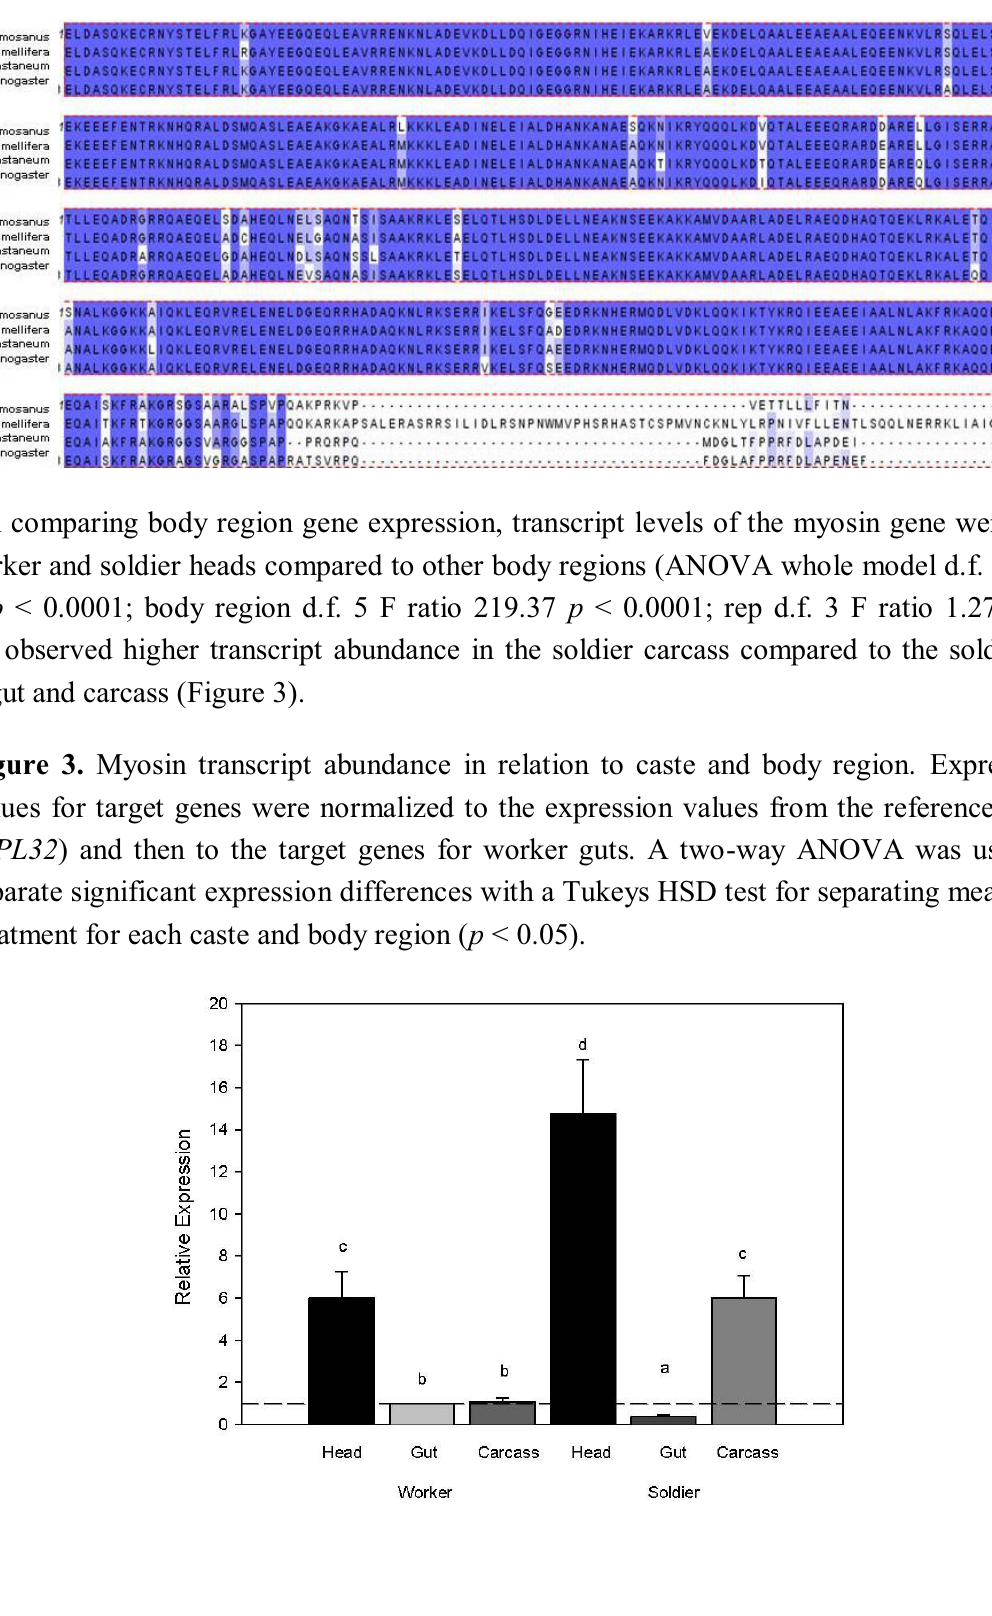
Figure 2. The predicted translation of available C. formosanus myosin heavy chain cDNA (arbitrarily designated residues 1-491) was aligned against myosin heavy chain protein sequences from Apis mellifera isoform 1 (XP_393334, residues 1688-2248), Tribolium castaneum (XP_001814139, residues 1793-2287), and Drosophila melanogaster (NP_724007, residues 1465-1962) using the Clustal W program [20]. Shading with purple background correlates with conservation (purple, identical; light purple; semi-conserved).